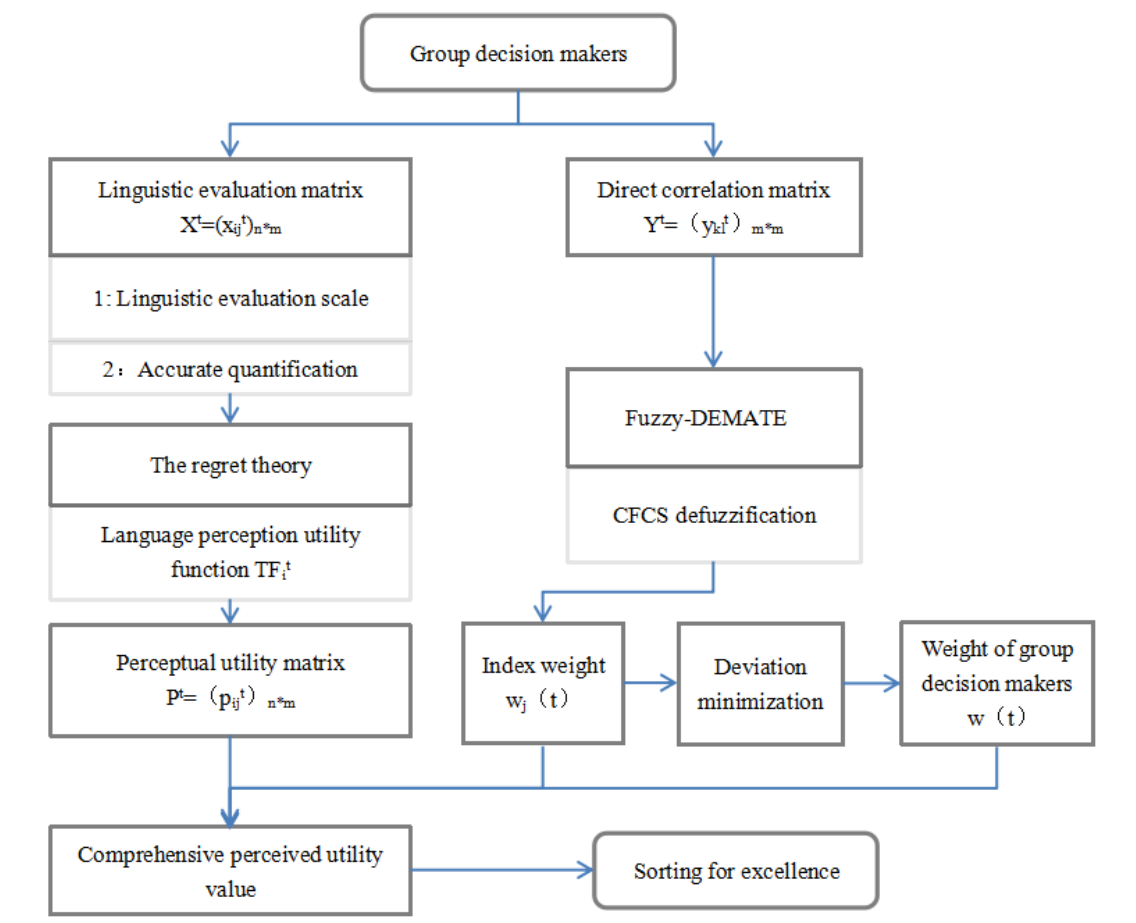
Figure 2. Linguistic Multi-attribute selection of construction program managers based on Regret Theory and Fuzzy-DEMATEL.